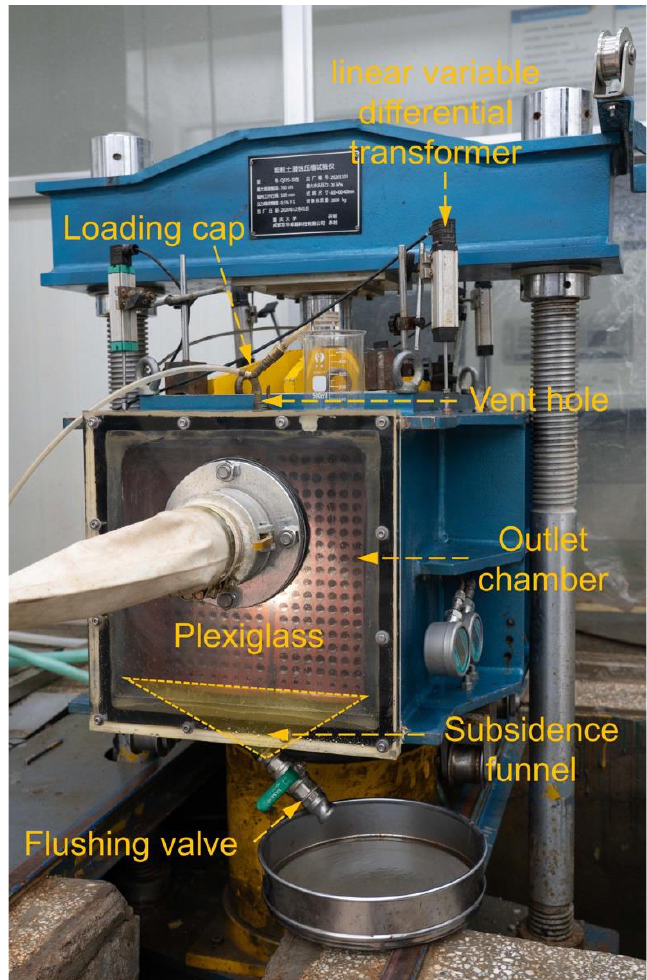
Figure 4. Photo of the erosion apparatus .